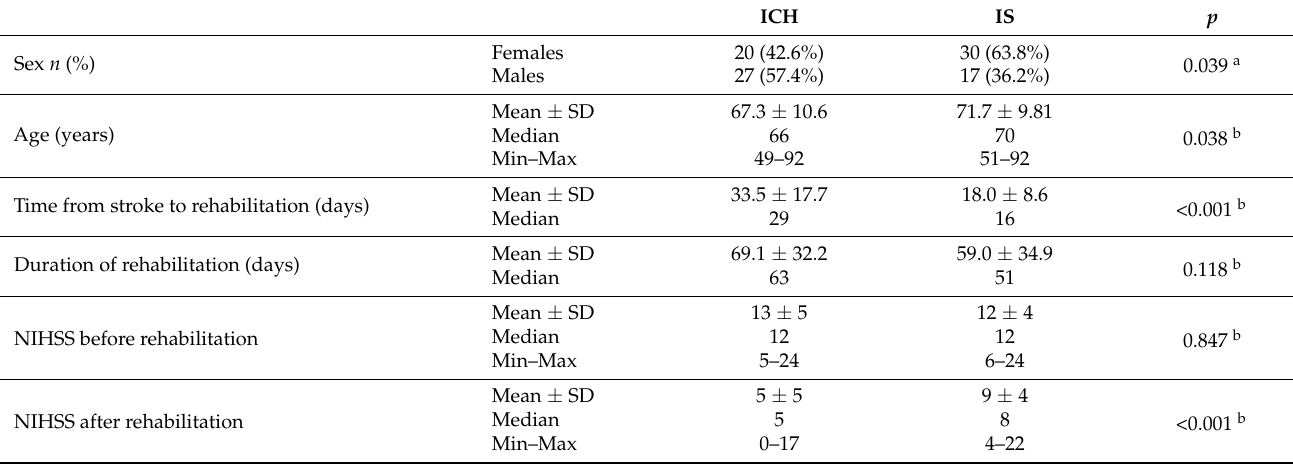
Table 1. Characteristics of the studied